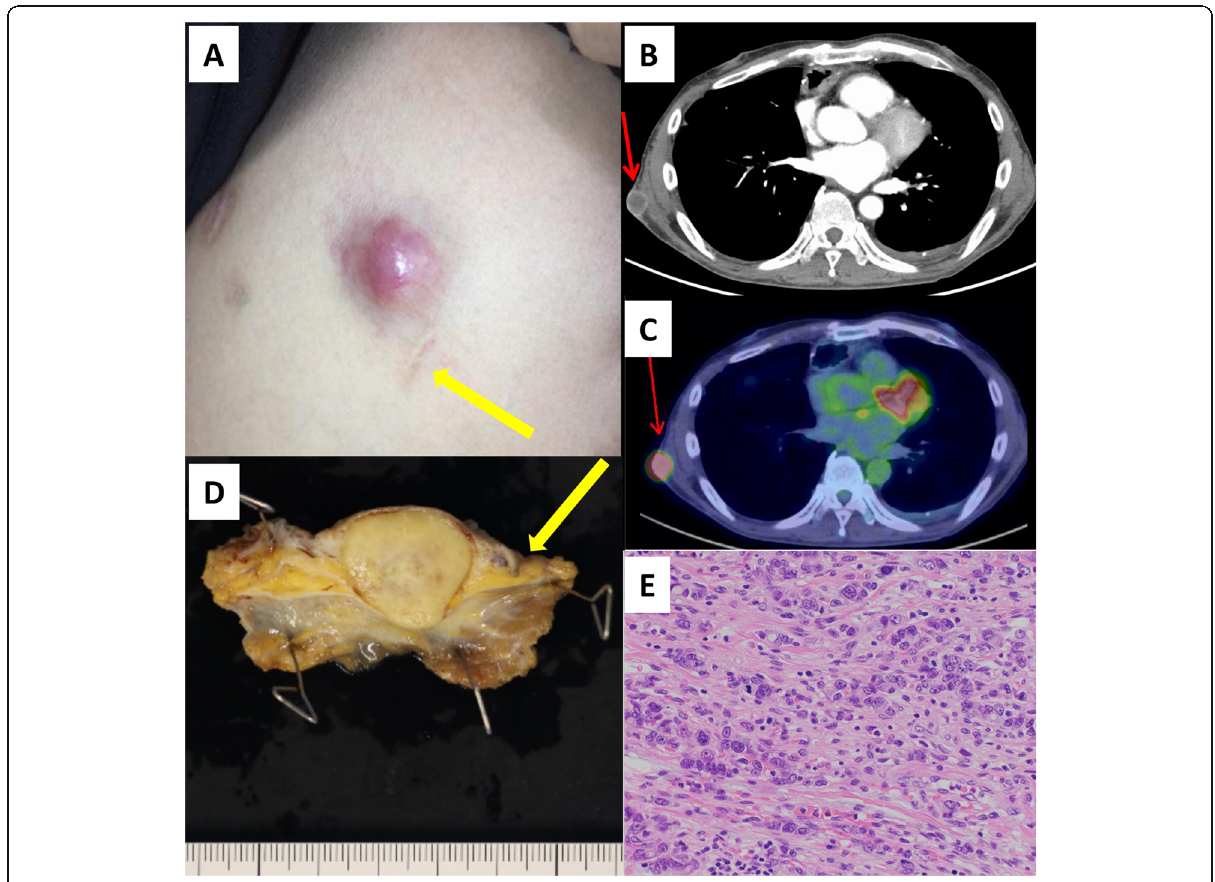
Fig. 1 a On the thoracic wall, there is an erythematous tumor that has the size of a thumb tip and is mobile. b Contrast CT demonstrates an enhancing tumor that is separated from the ribs. c PET-CT shows uptake in the tumor site. d Macroscopic image of the resected tumor. e Histopathologic image of recurrent tumor (hematoxylin and eosin stain). Yellow arrow shows the scar of the 5-mm surgical port site. Red arrow shows the recurrent